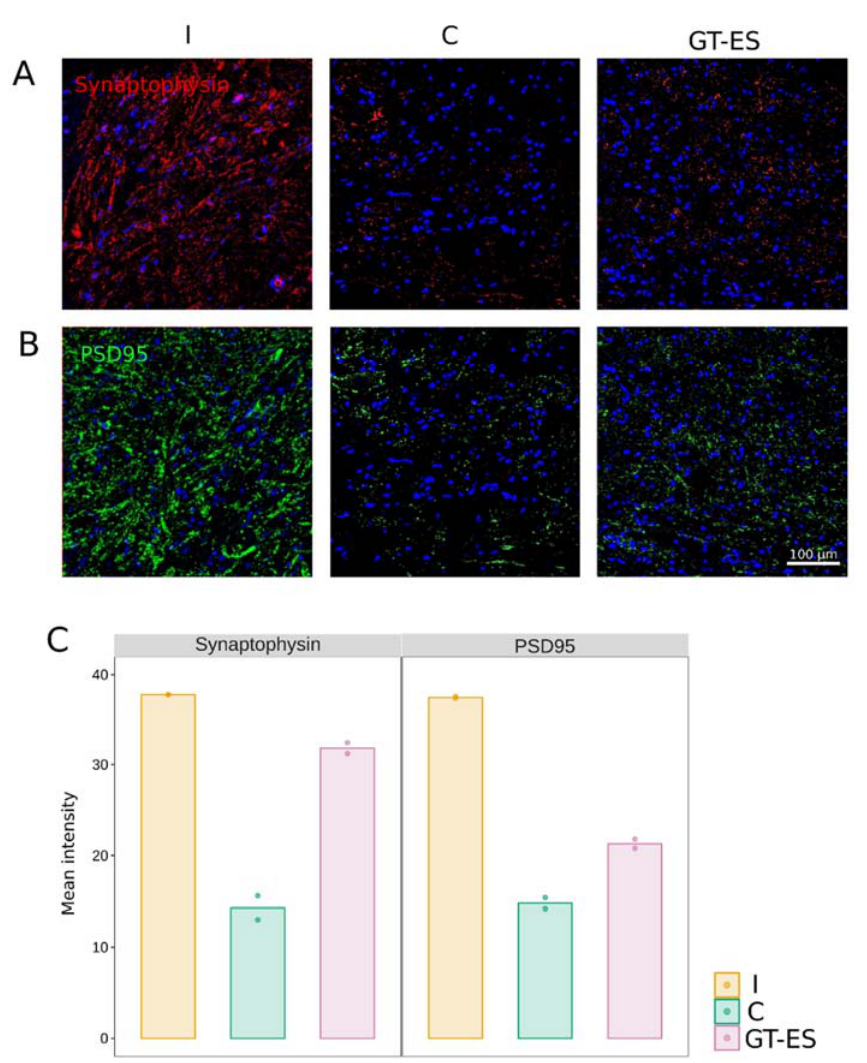
Figure 6. Immunoexpression of synaptic proteins in spinal cord ventral horns at 60 days after SCI. ( A ) Immunofluorescent staining with antibodies to Synaptophysin (synaptic vesicles protein). ( B ) Immunofluorescent staining with antibodies to postsynaptic density protein 95 kDa (PSD95). ( C ) Merged images representing Synaptophysin and PSD95. Nuclei are counterstained with DAPI (blue). Values averaged within animals are presented as points; bars represent group-wise average values.